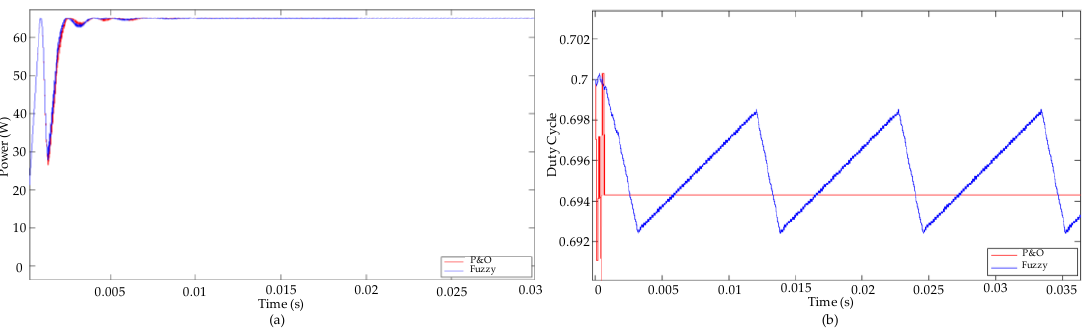
Figure 14. PV system with E i = 1000 W/m 2 and T = 25 °C. ( a ) Output power of the PV module; ( b ) Duty cycle.